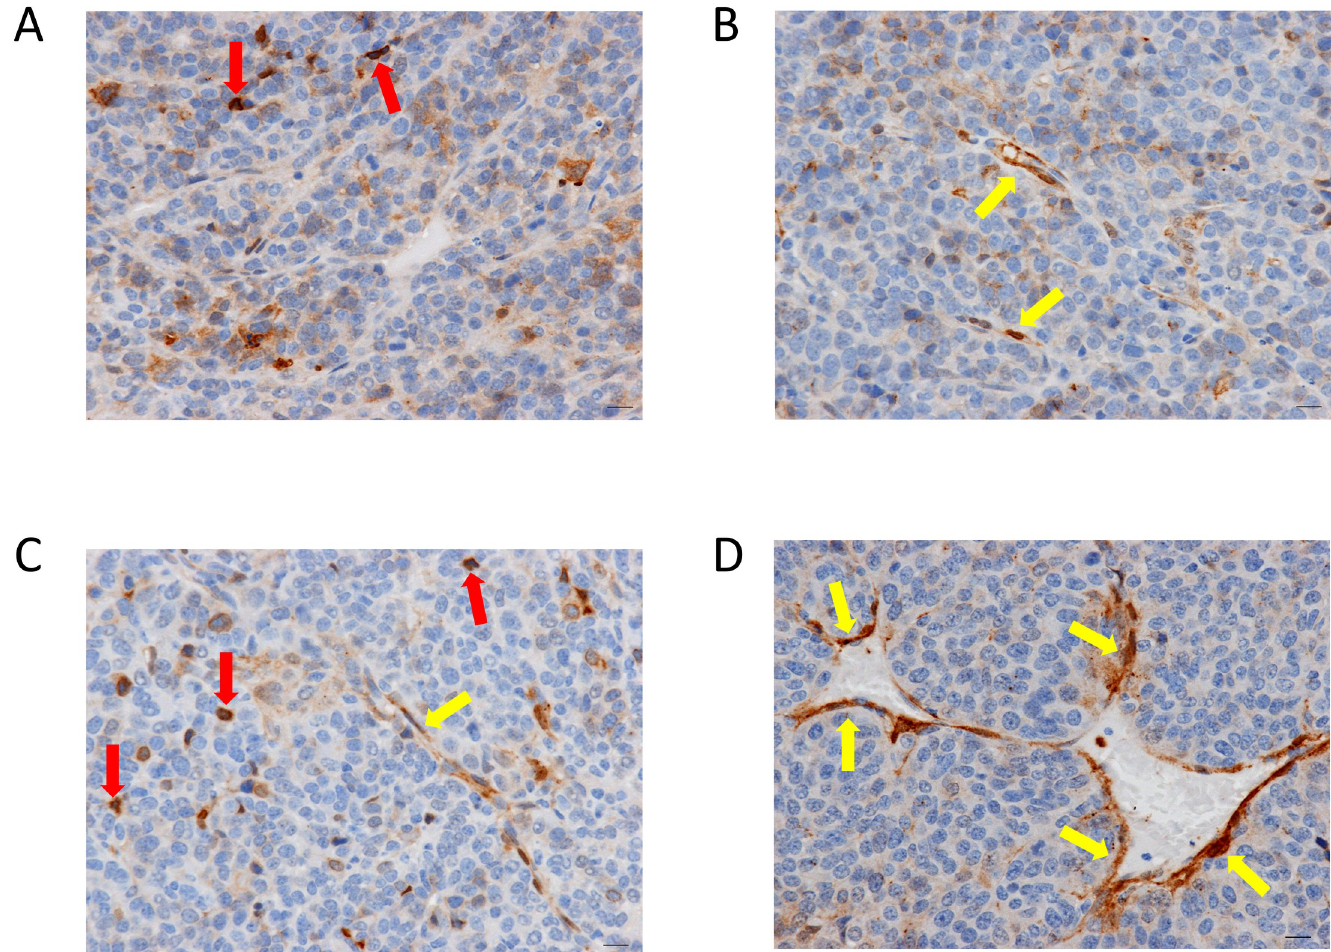
Fig 4. Time course of anxA1 expression in Py230 orthotopic breast tumor model. Immunohistochemical expression of anxA1 (brown) in Py230 tumors at (A) day 25, (B) day 30, (C) day 35, and (D) day 44. Microvascular endothelial cell expression of anxA1 (yellow arrows) begins at day 30 and increases in extent and intensity through day 44. Note that macrophages also exhibit strong anxA1 expression (red arrows). All scale bars = 10 μ m.